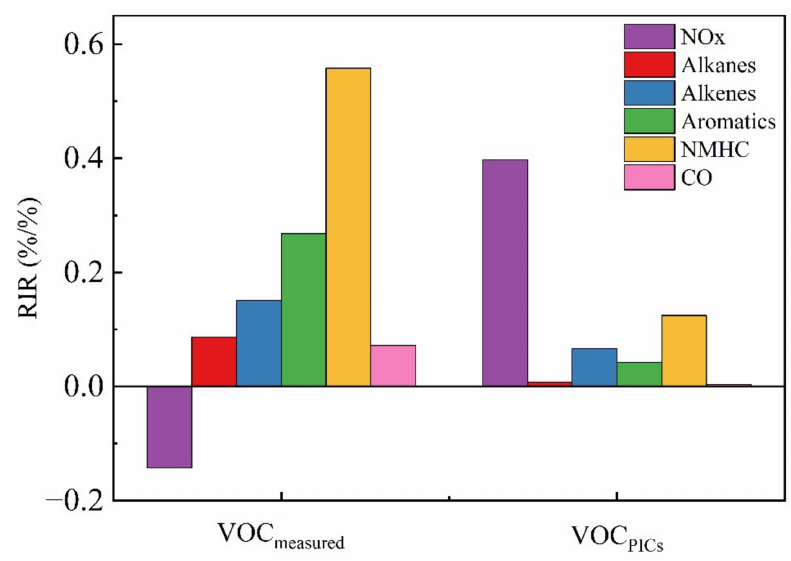
Figure 8. RIR values for NOx, Alkanes, Alkenes, Aromatics, NMHC, and